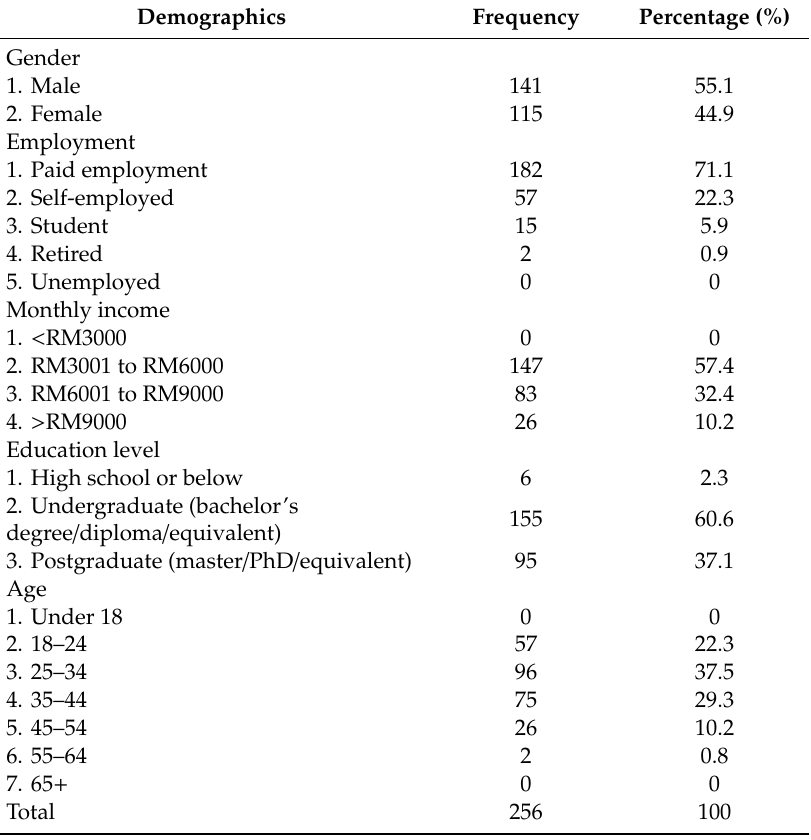
Table 2. Demographic profile of